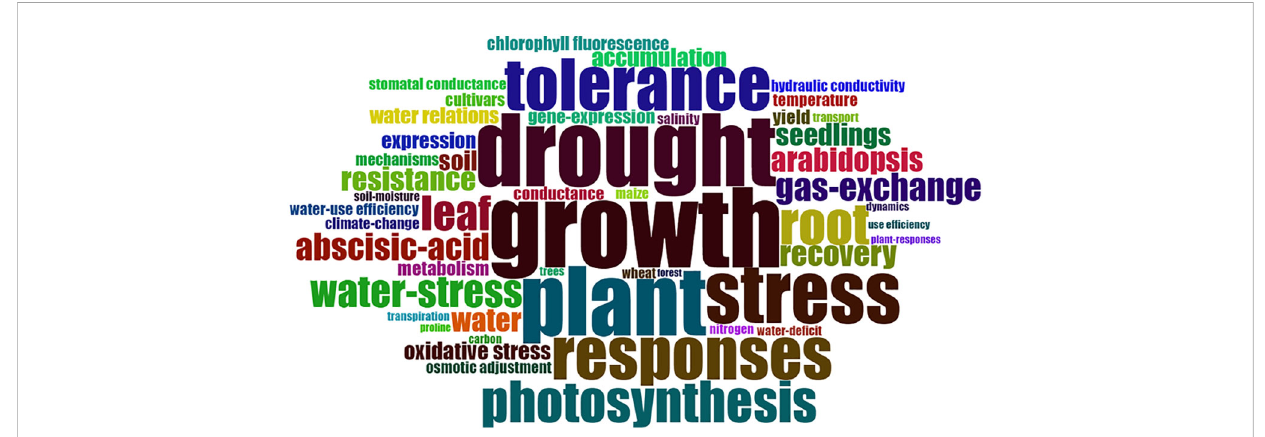
FIGURE 2 Top 50 keywords represented by the word cloud; labels are usually single words. and the frequency of each label is shown with font size. The biggest word “ growth ” appeared 266 times with a frequency of 7%, while the smallest word “ forest ” only showed up 26 times with a frequency of 1%.